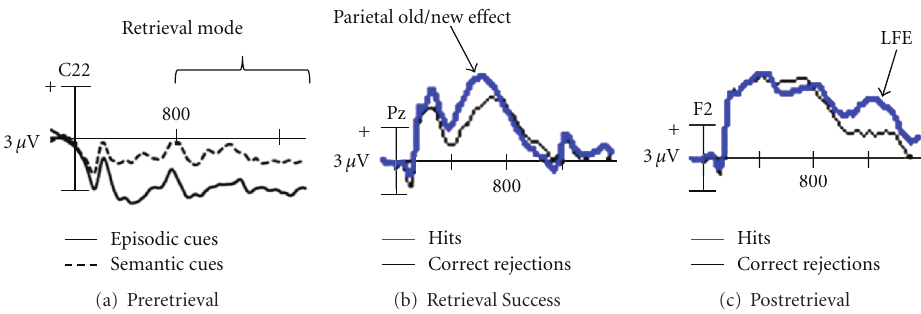
Figure 3: Waveforms reflecting ERP e ff ects associated with three stages of memory retrieval. (a) Preretrieval processing: example “retrieval mode” e ff ect in young adults, from Wilckens et al. [22]. Retrieval mode e ff ects are most robust in anterior and right-sided electrode sites (C22 from a 128-electrode layout shown here). Retrieval mode e ff ects are typically associated with a sustained divergence between ERPs elicited by cues to prepare for episodic memory judgments and semantic memory judgments, starting around 800ms following task cue onset [22, 23]. (b) Retrieval success: example parietal old/new e ff ect in young adults, from Wolk et al. [49]. The parietal old/new e ff ect is most robust in left posterior electrode sites (Pz from a 35-electrode layout shown here). The parietal old/new e ff ect is associated with more positive-going ERPs elicited by correctly identified studied information (hits) compared with correct rejections (CRs) between 500–800 ms after memory probe onset. The parietal old/new e ff ect reflects successful recovery of a memory trace, often for memory details [58]. (c) Postretrieval processing: example late frontal e ff ect (LFE) in older adults from Wolk et al. [49]. The LFE is most robust in right anterior electrode sites (F2 from a 35-electrode layout shown here). The LFE is associated with more positive-going hits than CRs starting around 1000 ms after memory probe onset and later in right anterior sites [45, 61]. A late-correction strategy would predict that older adults would show diminished retrieval mode (a) and parietal old/new (b) e ff ects, but the LFE (c) would be intact or greater in older adults. Though these e ff ects may be exhibited during simple recognition memory due to spontaneous engagement of retrieval strategies and retrieval of details, these ERP e ff ects are associated more with cue-induced retrieval, rather than stimulus-driven retrieval (i.e., a retrieval mode is engaged across a block of recognition memory judgments suggesting that processing is biased in favor of memory